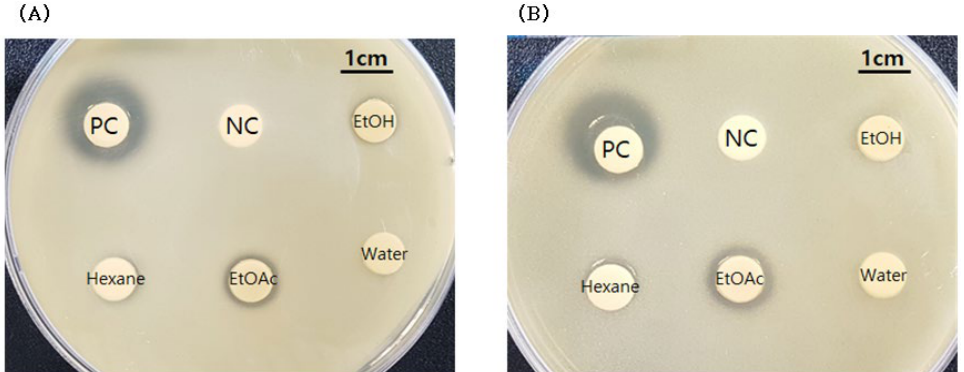
Figure 1. Antimicrobial activity of fractions of Smilax china L. root extract. ( A ) Cutibacterium acnes KCTC 3314; ( B ) Cutibacterium acnes KCTC 3320. PC, positive control (Erythromycin, 5 μg/mL in DMSO); NC, negative control (DMSO, 100%); EtOH, ethyl alcohol-soluble fraction; Hexane, hexane-